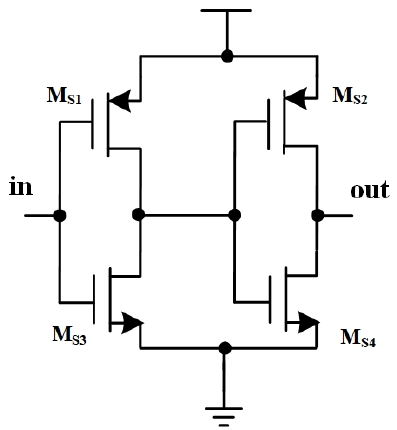
Figure 4. Structure of the delay unit in the sensing module.